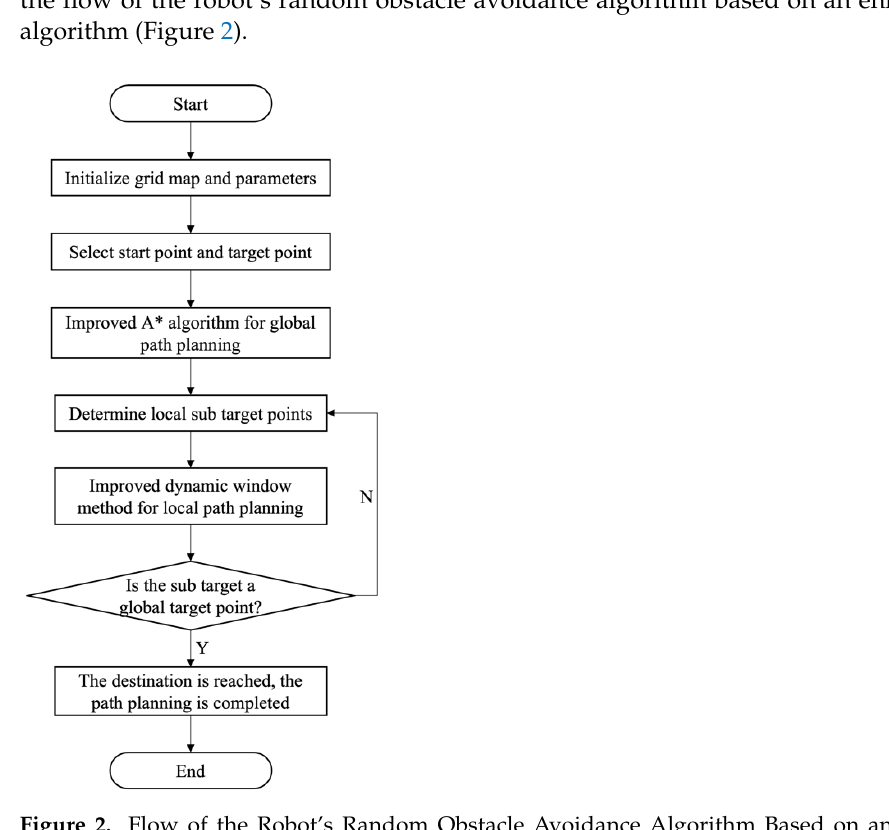
Figure 2. Flow of the Robot’s Random Obstacle Avoidance Algorithm Based on an Improved A* Algorithm.